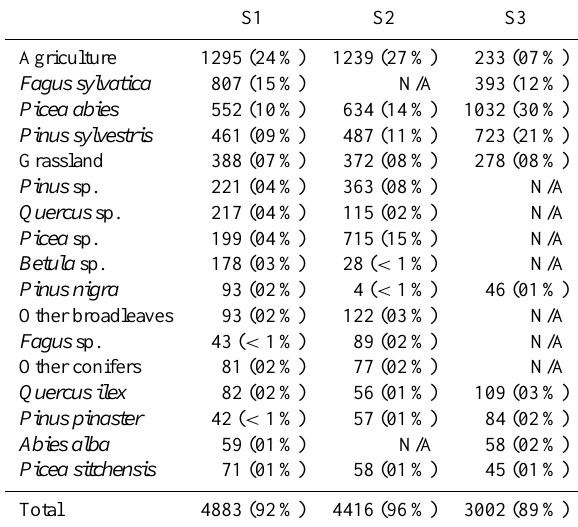
Table 5. Top emitters of OVOC (based on annual data, original countries), selected so that at least the ten most important emitters for each inventory is shown. Values in Gg yr − 1